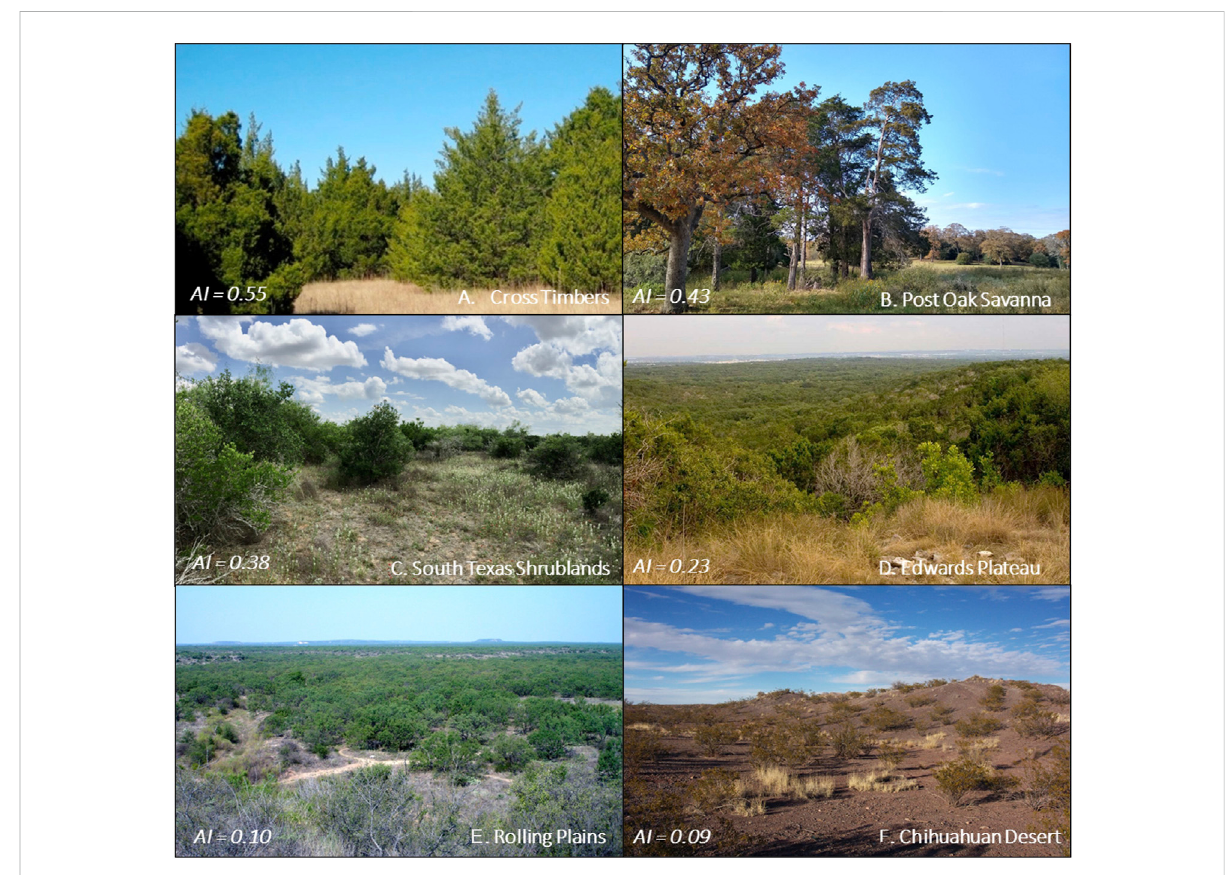
FIGURE 1 The six ecoregions represented by the case studies on which our evaluation is based: (A) . Case Study 1--Cross Timbers of Oklahoma; (B) . Case Study 2--Post Oak Savanna in Texas; (C) . Case Study 3 — South Texas Shrublands; (D) . Case Study 4 — Edwards Plateau of Texas; (E) . Case Study 5 — Rolling Plains of Texas; and (F) . Case Study 6 — Chihuahuan Desert of New